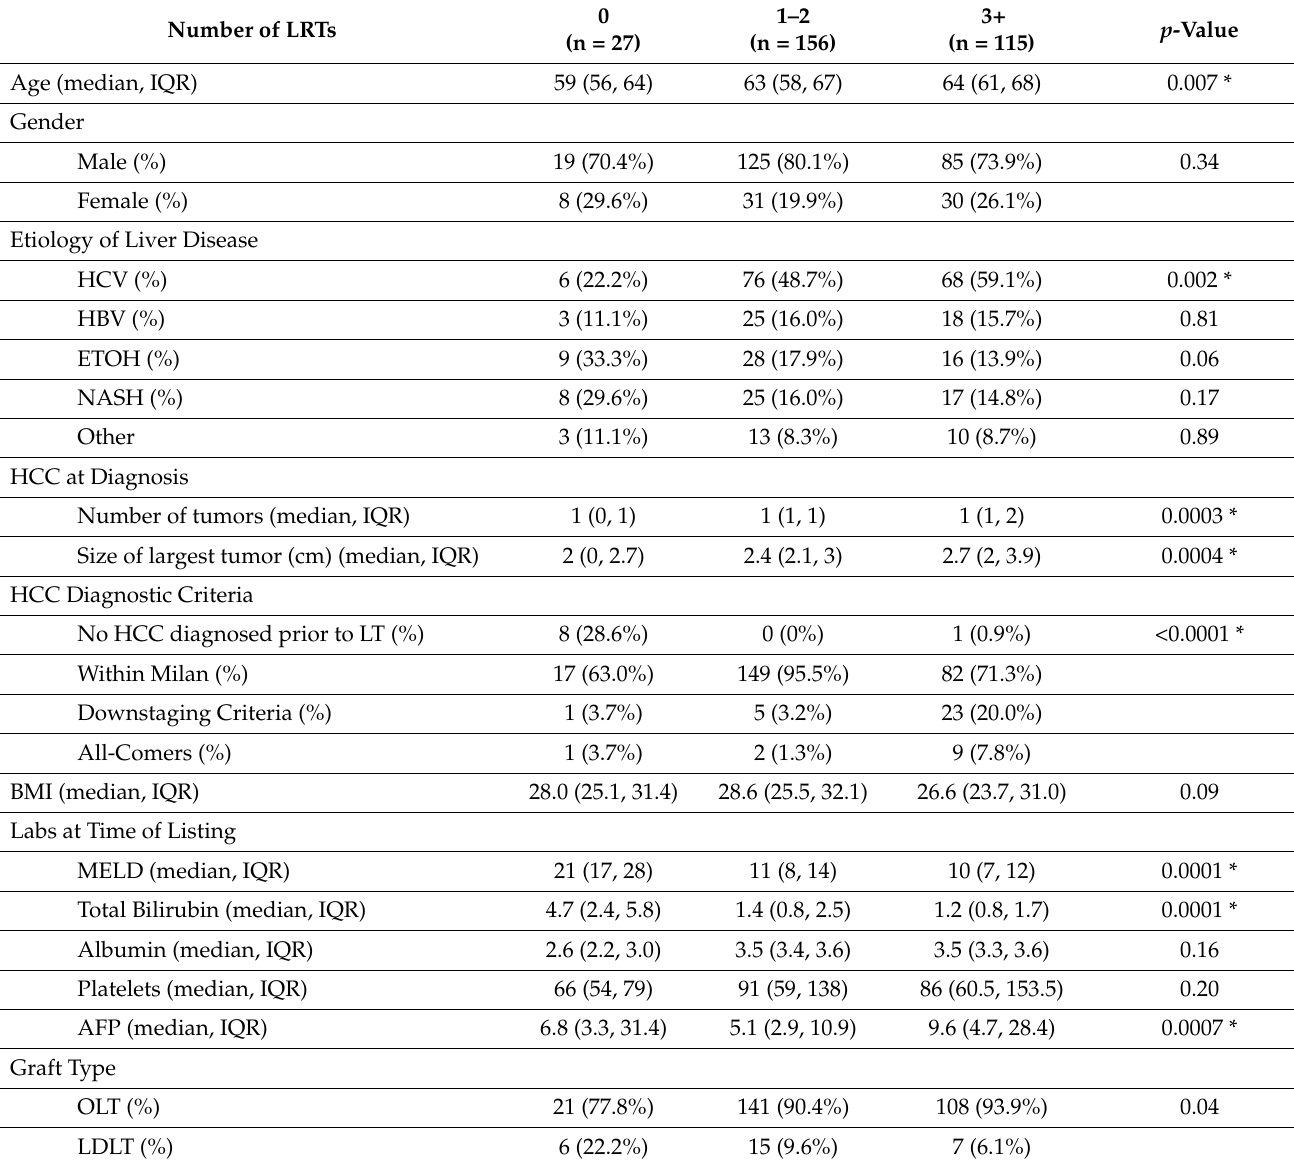
Table 1. Demographic and Clinical Characteristics of Liver Transplant